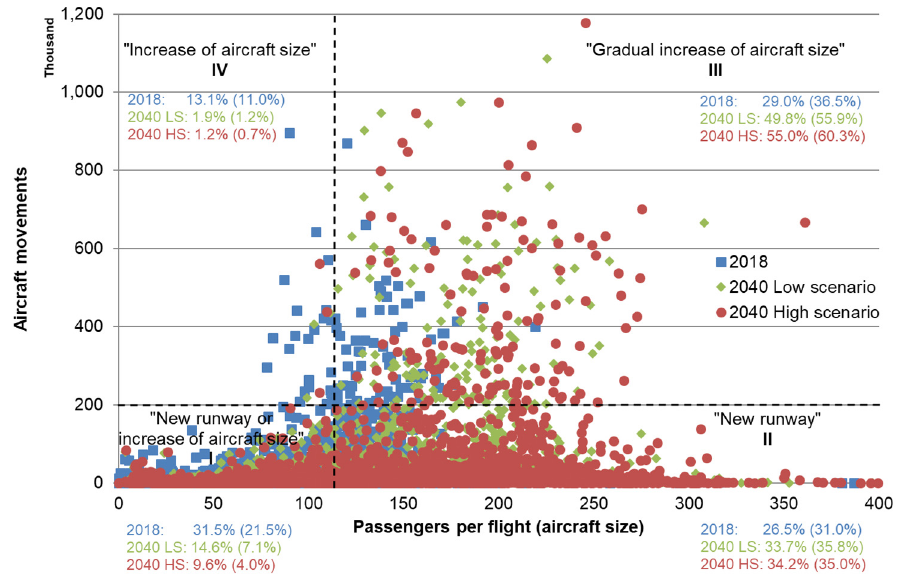
Figure 7. Global classification of airports according to mitigation strategies and their share of global aircraft movements for the years 2018, 2040 low scenario (LS), and 2040 high scenario (LS) (in brackets: airports’ share of global passenger volume), 2018 data are taken from Sabre Market Intelligence [36, own illustration and forecast].